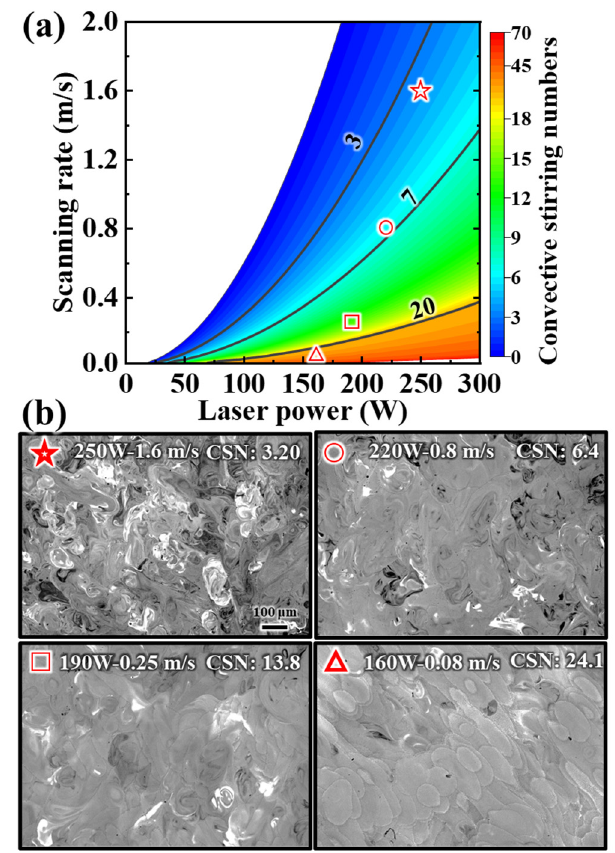
Figure 10. Processing map and experiment results of in-situ alloyed Al20Cu: ( a ) processing map shows the convection stirring number as a function of laser power and scanning rate. ( b ) BSE micrograph of the samples printed at various scanning rates and laser powers.